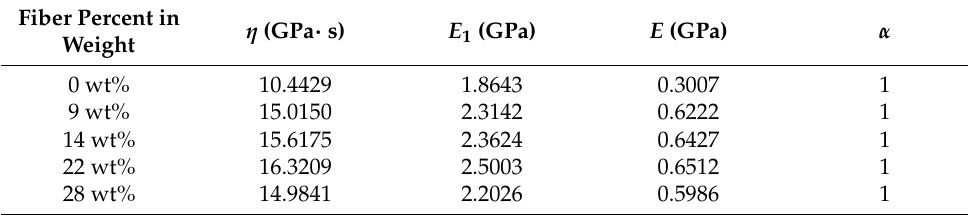
Table 1. Parameters of the integer model.